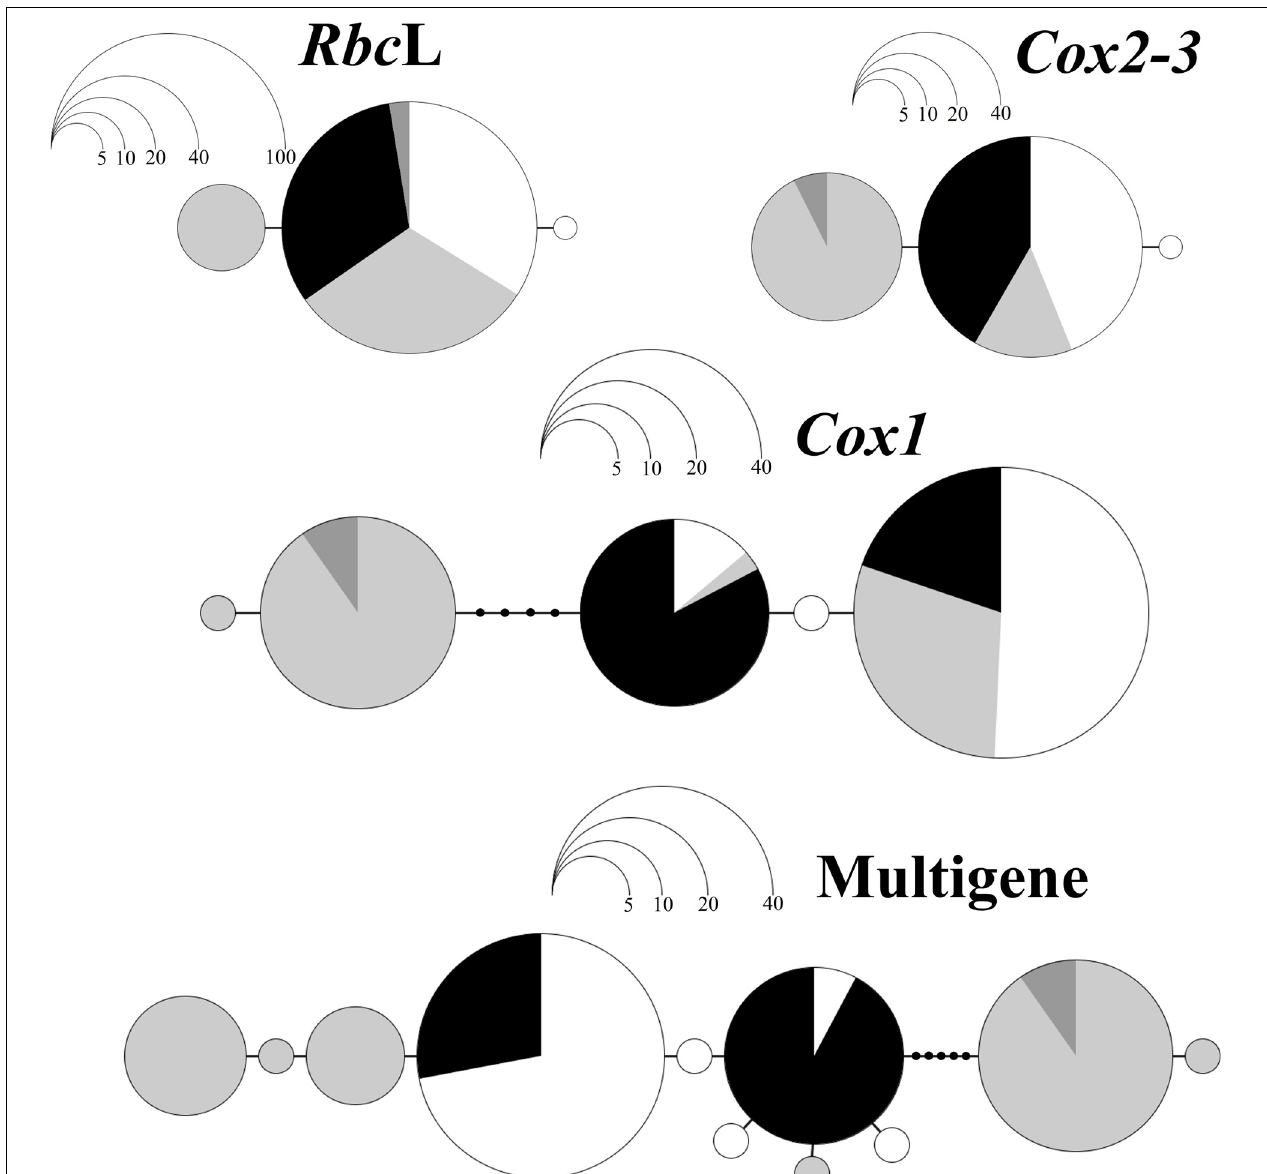
FIGURE 3 | Haplotype Networks of Botryocladia occidentalis in three regions of the Gulf of Mexico. CB, Campeche Banks (white); LA, offshore Louisiana before the Deepwater Horizon Oil Spill (DWH; black); L2, offshore Louisiana after the DWH (dark-gray); FL, Florida Middle Grounds (light-gray). The networks are based on different genes: the RuBisCO large subunit ( rbc L), the COX II-III intergenic spacer region ( Cox2-3 ), cytochrome c oxidase subunit I ( Cox1 ), or the three genes combined. Each circle represents an allele while their size indicate their abundance in number of individuals. The position of alleles in the diagram reflects their ML phylogeny: closely related alleles are next to each other while more divergent alleles are farther. The genetic divergence was calculated with the T92 model, except in the multigene network, which used the HKY